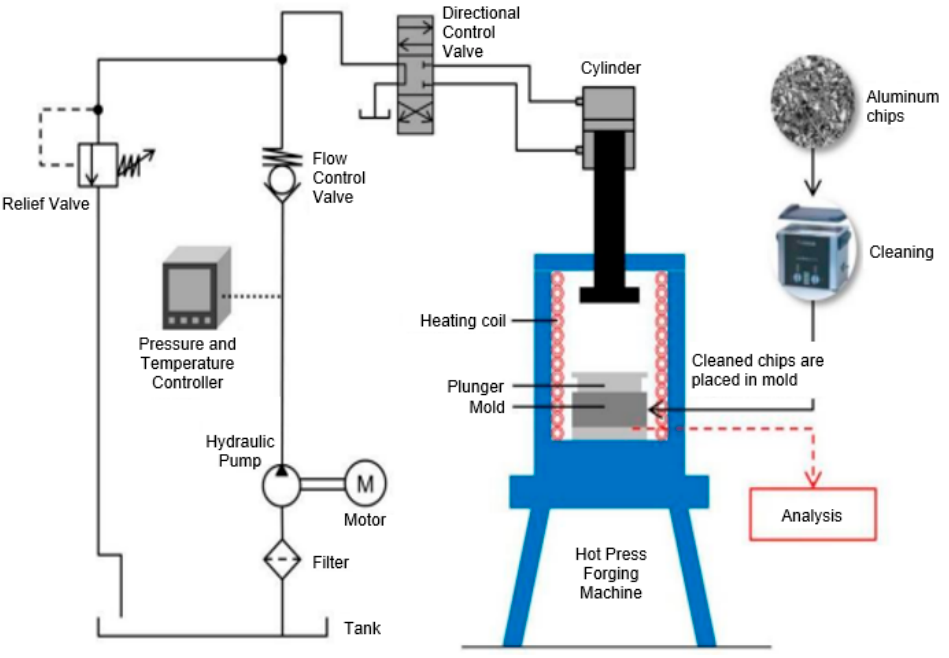
Figure 1. Experimental set-up of the hot press forging (HPF) process [68].